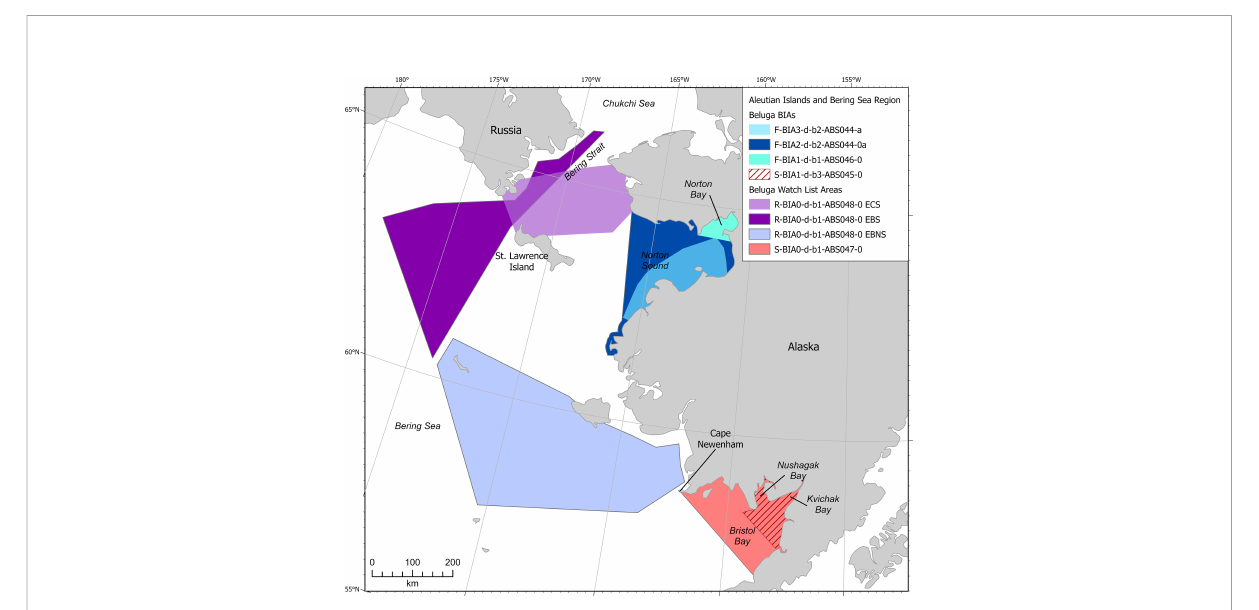
FIGURE 9 Aleutian Islands and Bering Sea region beluga BIAs and watch list